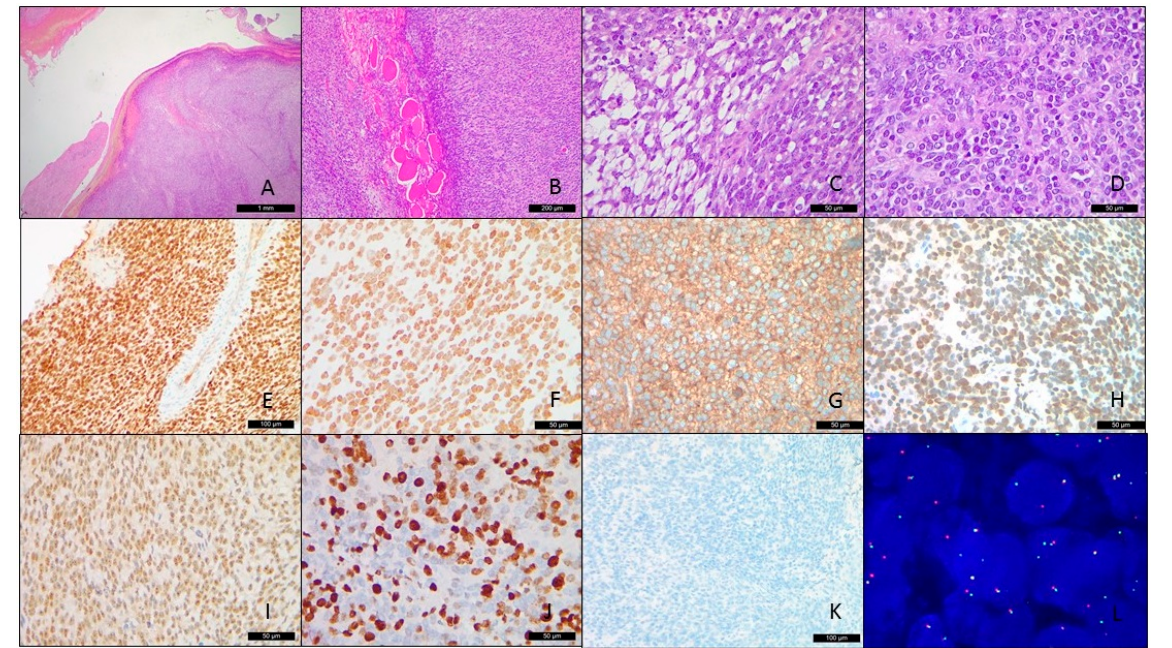
Figure 2. Microscopically lobulated tumor cells (( A ), H&E, 2.5×) with infiltration into the skeletal muscle (( B ), H&E, 10×). The ovoid- and spindle-shaped tumor cells possessed vesicular chromatin, prominent nucleoli, and minimal eosinophilic cytoplasm within the fibromyxoid stroma ( C , D ), H&E, 40×). The immunohistochemistry stain showed positivity for BCOR (( E ), ×20), TLE1 ( F ), ×40), CD99 (( G ), ×40), SATB2 (( H ), ×40), INSM1 (( I ), ×40) with a high MIB1 labeling index ( J ), ×40) and the pan-cytokeratin stain was negative (( K ), 40×). The fluorescence in situ hybridization revealed BCOR break-apart signals ( L ).